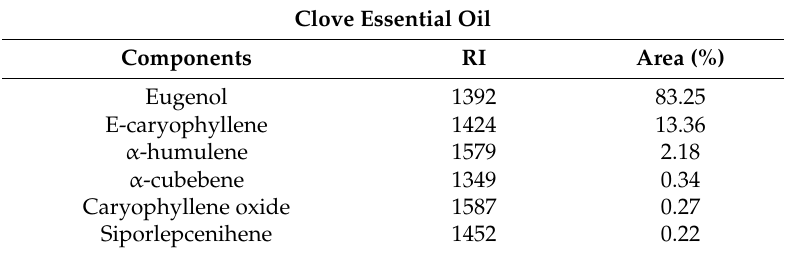
Table 2. GC-MS analysis of clove essential oil showing major chemical components; RI: retention index literature comparison; the remaining compounds were in traces ( <